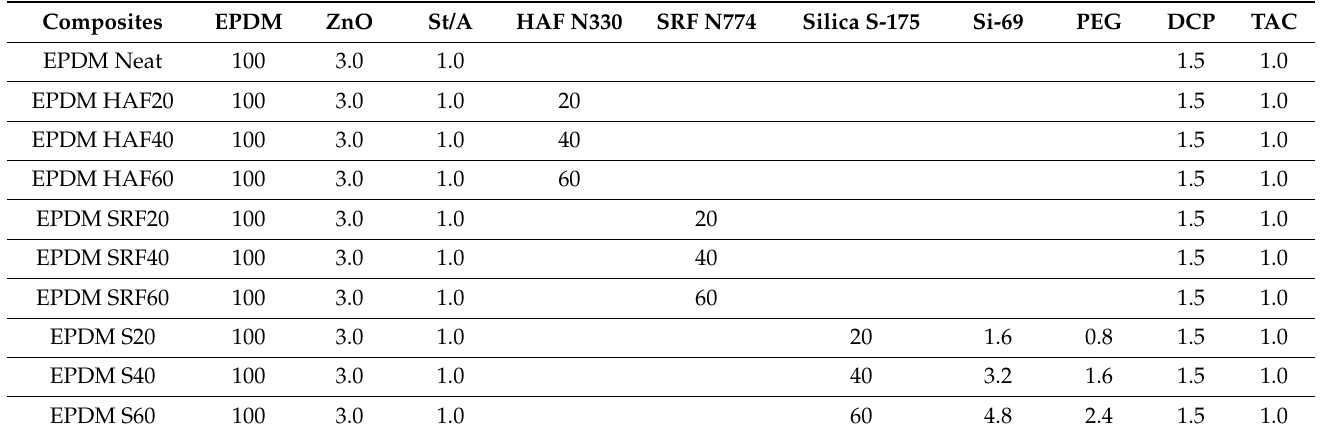
Table 3. Chemical compositions of peroxide-crosslinked EPDM polymer composites blended with HAF CB, SRF CB, and silica